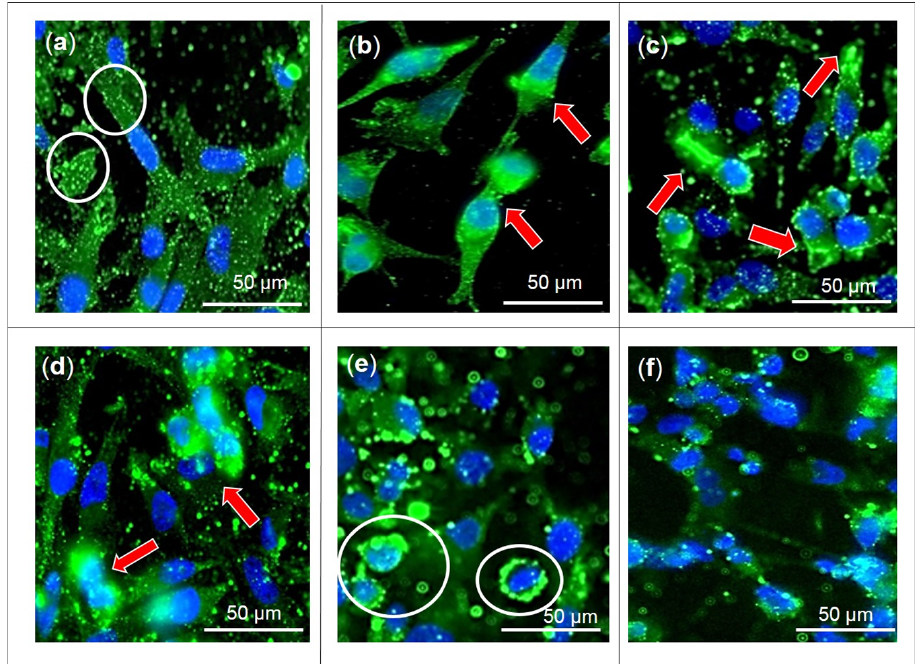
Figure 3. Localization of GLUT1 to the cell membrane. MDA-MB-231 cells were untreated (negative control; ( a ) or treated with the indicated concentrations of ( b ) F3, ( c ) lutein, ( d ) β -sitosterol, ( e ) stigmasterol, and ( f ) apigenin (positive control) for 24 h. GLUT1 expression and localization to the cell membrane was observed under a fluorescence microscope at 400× magnification. Red arrows show an abundance of green punctate in the nucleus and cytoplasm area of treated cells. White circles show GLUT1 localization at the plasma membrane.